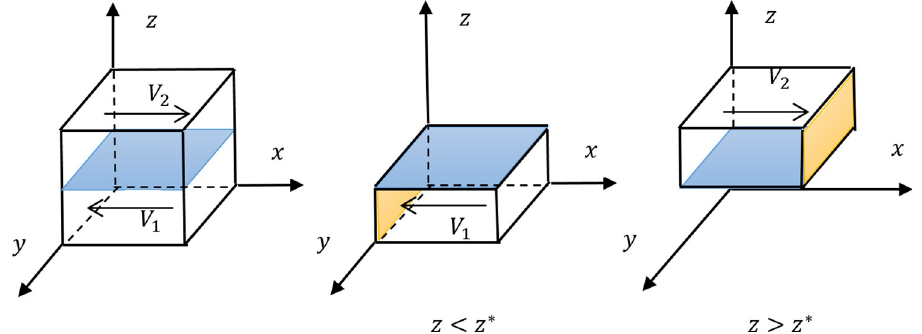
Fig 1. The evolution trend diagram of the formal